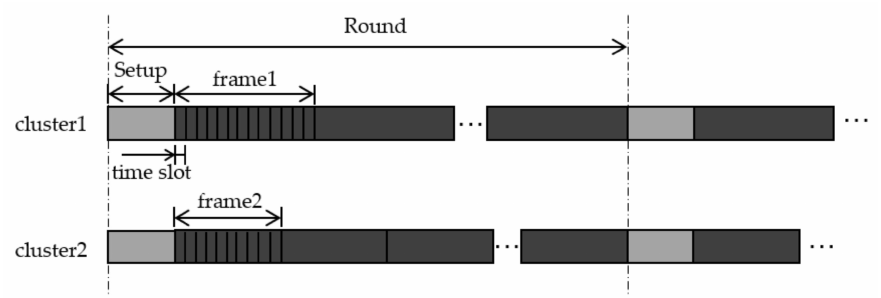
Figure 2. The TDMA schedule of two clusters. Cluster1 is a larger cluster with more nodes than cluster2. The gray grids represent the set-up phase, and the black grids represent the steady- state phase.